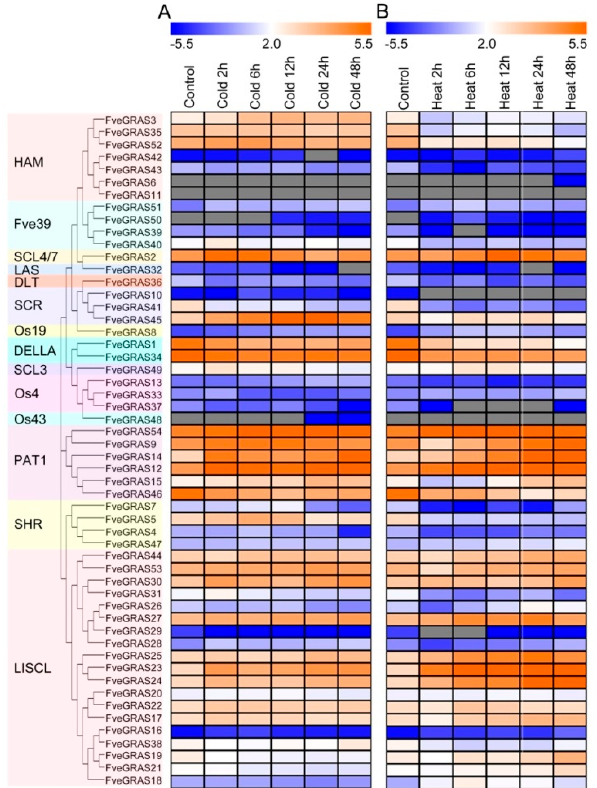
Figure 6. Expression changes of GRAS genes of woodland strawberry under cold and heat stresses. ( A ) Expression changes of GRAS genes of woodland strawberry under cold stress. ( B ) Expression changes of GRAS genes of woodland strawberry under heat stress. Woodland strawberry variety “Hawaii 4” seedlings were used for cold (4 °C) and heat (40 °C) treatments. FPKM values were in Supplementary Table S9, and the heat map showed log2 level.